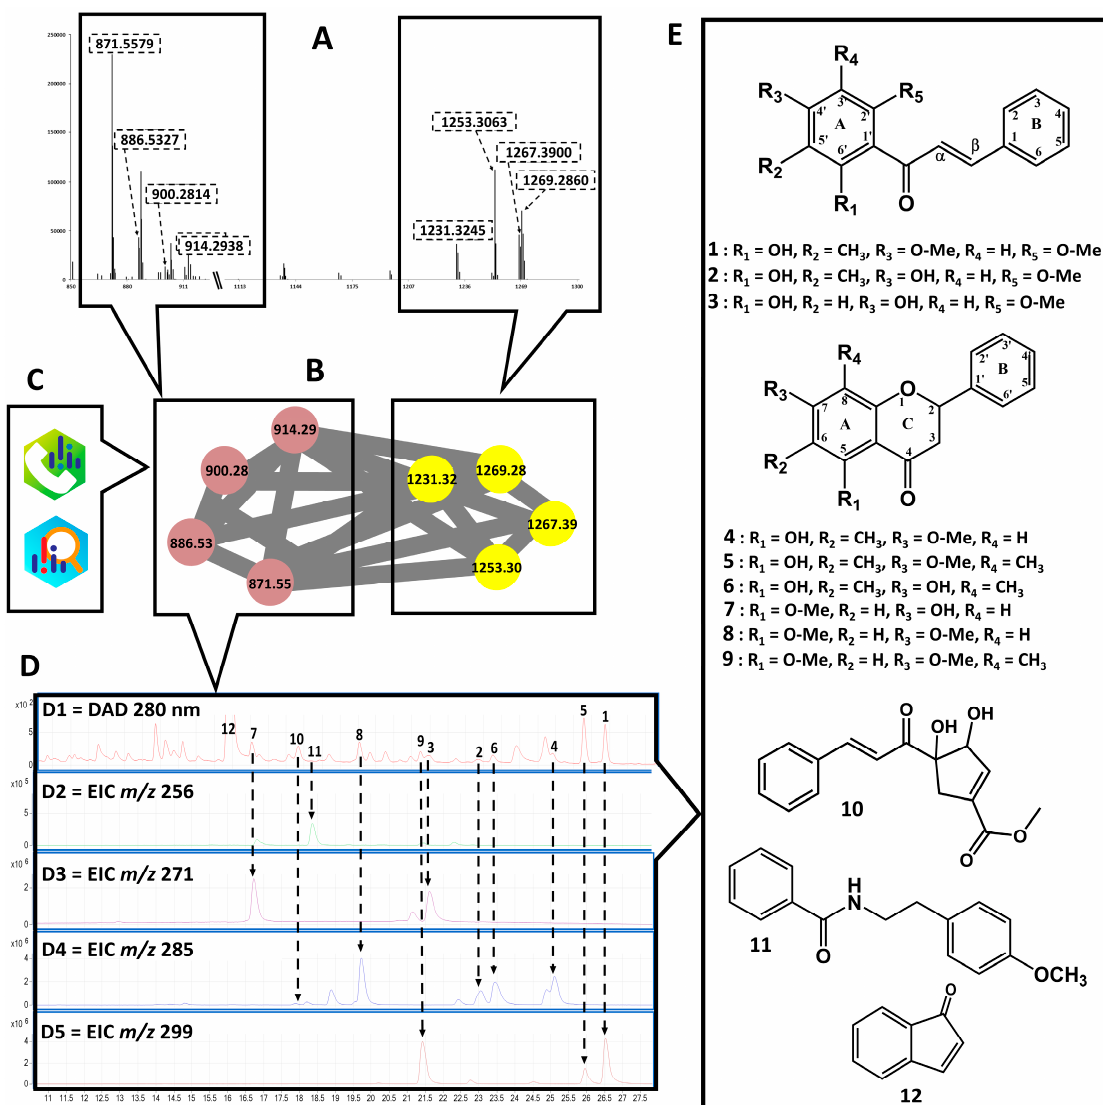
Figure 3. Biodereplication workflow by MS from P. coruscans leaves extract. MS spectrum of heme– extract mixture showing the region of adducts (left, dotted square) and the region of heme dimers (right, dotted square) ( A ). Network showing targeted adducts grouped in the same cluster (left square) and heme dimers (right square) ( B ). Annotation of compounds identified using MS-Dial and MS-Finder ( C ). LC-DAD (280 nm) chromatogram of ethanolic extract from P. coruscans ( D1 ). Extract ion chromatogram (EIC) corresponding to m / z 256 ( D2 ), m / z 271 ( D3 ), m / z 285 ( D4 ), and m / z 299 ( D5 ). Isolated target compounds from P. coruscans ( E ).